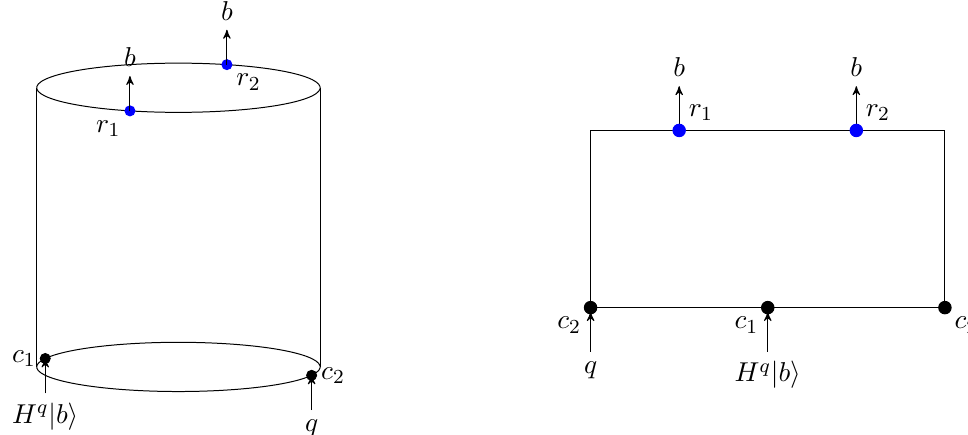
Figure 6. Bulk and boundary perspectives on the ^B 84 task. Generically, it may happen that the bulk geometry contains a central region P = J + ( c 1 ) \ J + ( c 2 ) \ J (cid:0) ( r 1 ) \ J (cid:0) ( r 2 ) while the boundary geometry does not. In order for the boundary task to be possible when the bulk one is, the boundary must make up for the lack of central region by having O ( N 2 ) entanglement between certain pairs of boundary regions, as we develop in detail in the